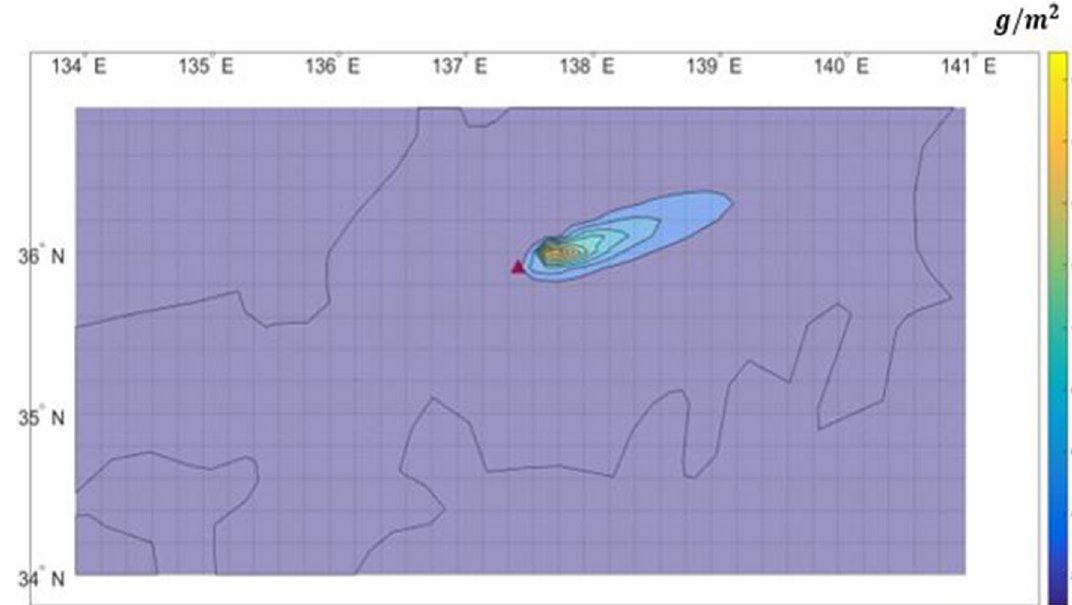
Figure 14. Deposition Results of PUFF–Gaussian Model (Ontake Volcano, February September 27, 2014).